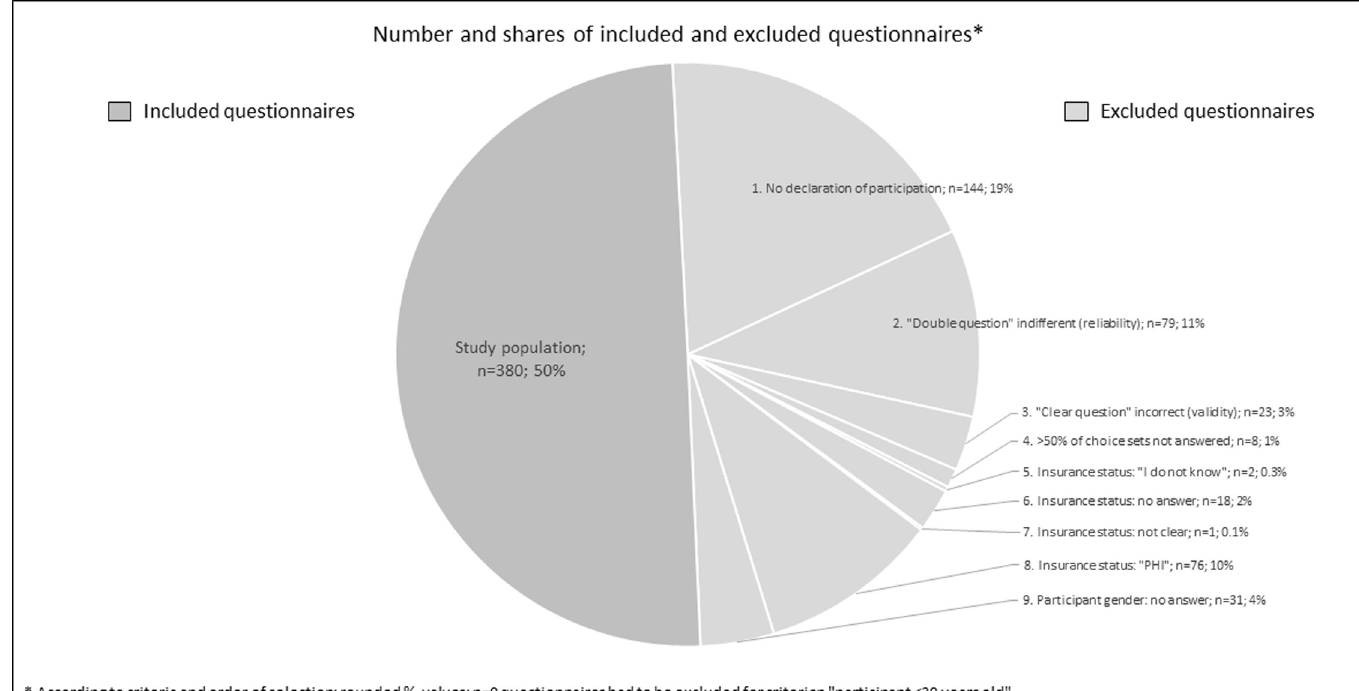
Fig 1. Selection of questionnaires and data sets, numbers regarding